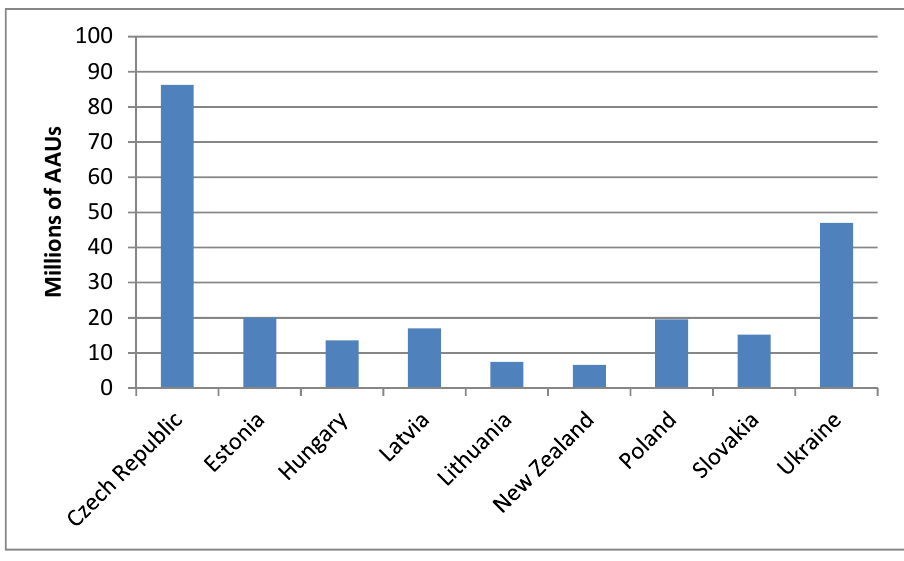
Figure 1. Assigned amount unit (AAU) Sales [19].